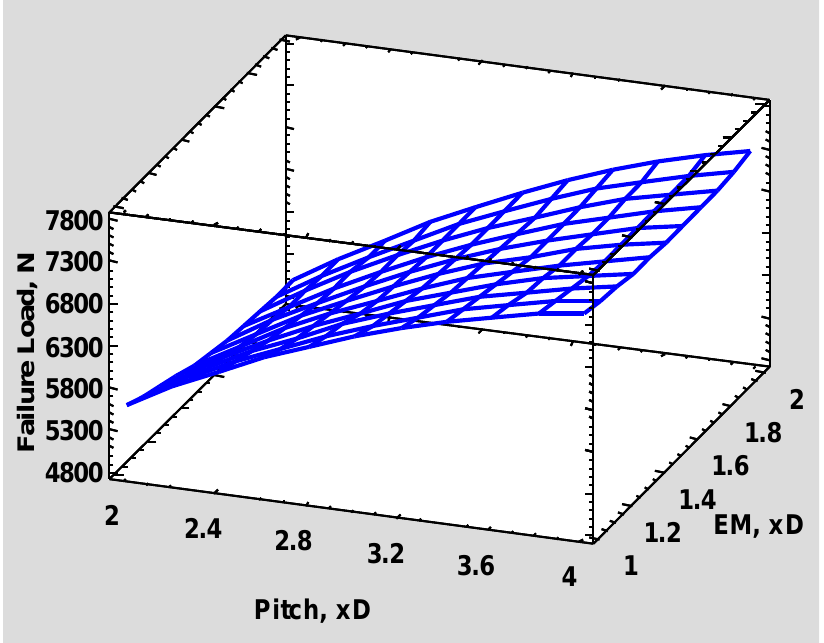
Figure 12. Estimated response surface of pitch and edge margin (EM). Notes: D = 7 mm (Spot Weld Diameter); pitch = Spot Weld Spacing.